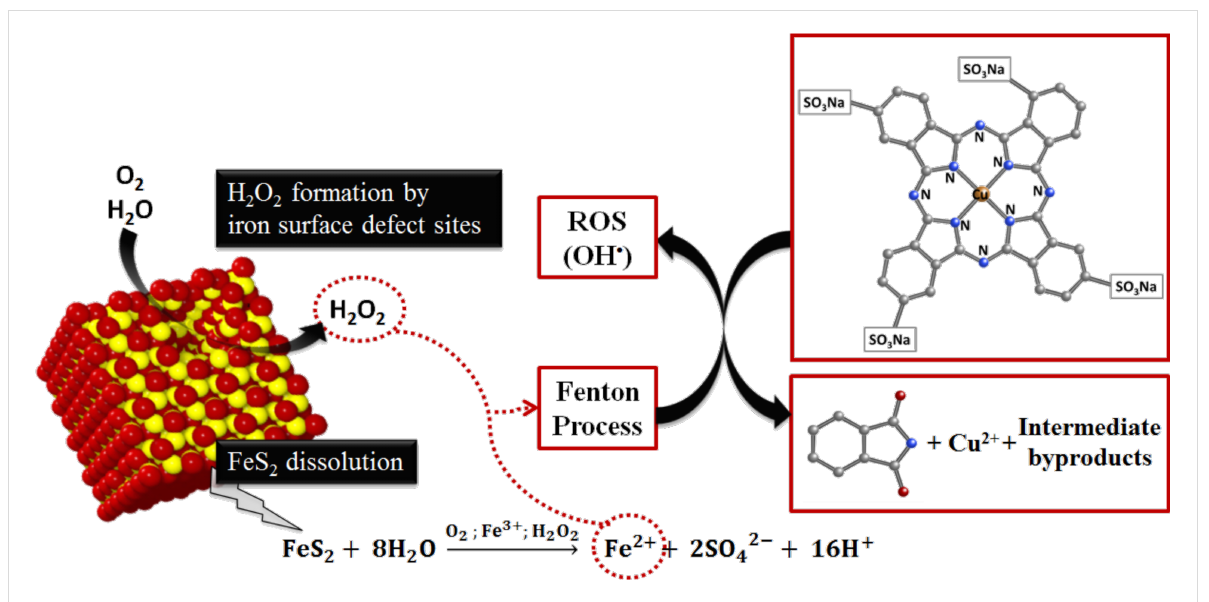
Figure 9: Proposed reaction mechanisms for the generation of H 2 O 2 and for the oxidative degradation of CuPc by OH • .